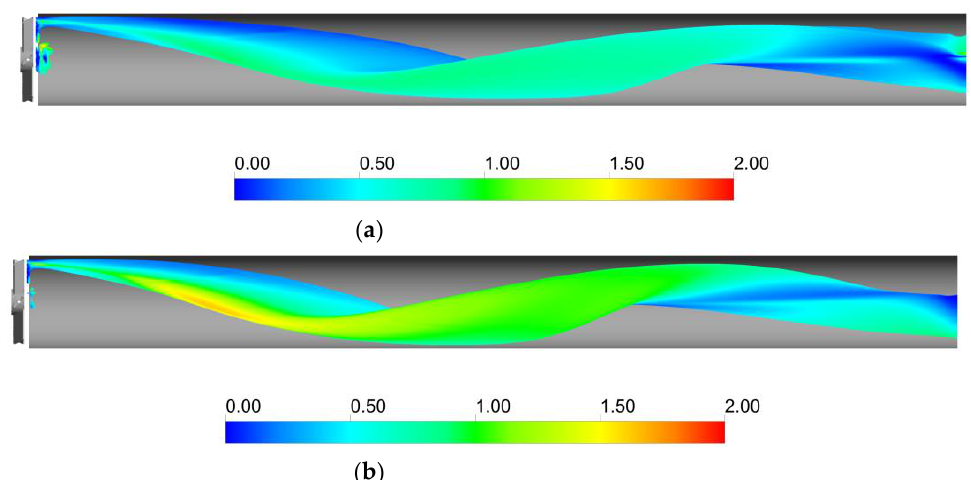
Figure 4. Iso-surfaces of a gas volume fraction downstream of the static mixer obtained at a value of α G = 0.025 for the operative conditions considered: ( a ) Q L = 25 m 3 /h and Q G = 3.75 L/min; ( b ) Q L = 30 m 3 /h and Q G = 7.5 L/min. The iso-surfaces are colored with the ratio between the centripetal acceleration and the gravitational acceleration.